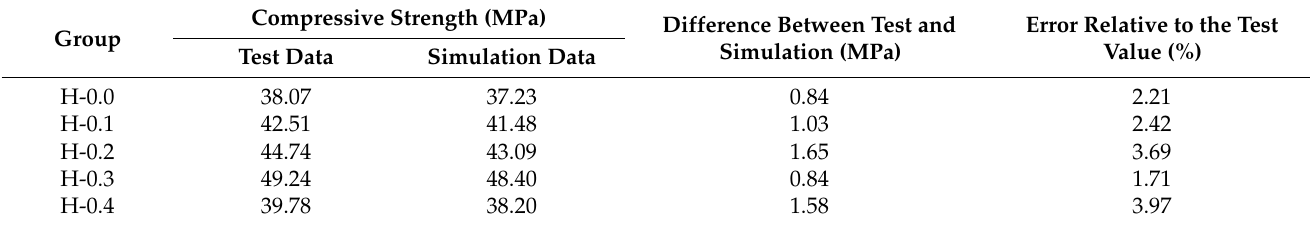
Table 13. Comparison of test and simulated compressive strength values of hybrid BF-PVAF-